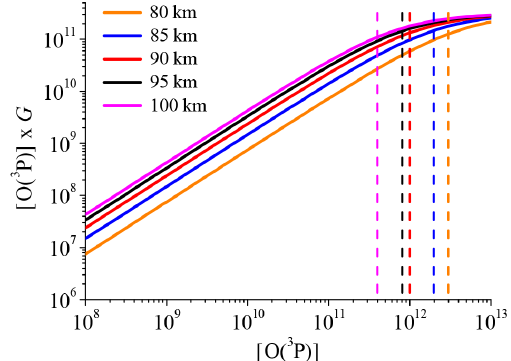
Figure 7. O ( 3 P ) × G as a function of O ( 3 P ) at different altitudes. The visually determined upper limits of O ( 3 P ) before non-linearity becomes too pronounced are represented by the dashed